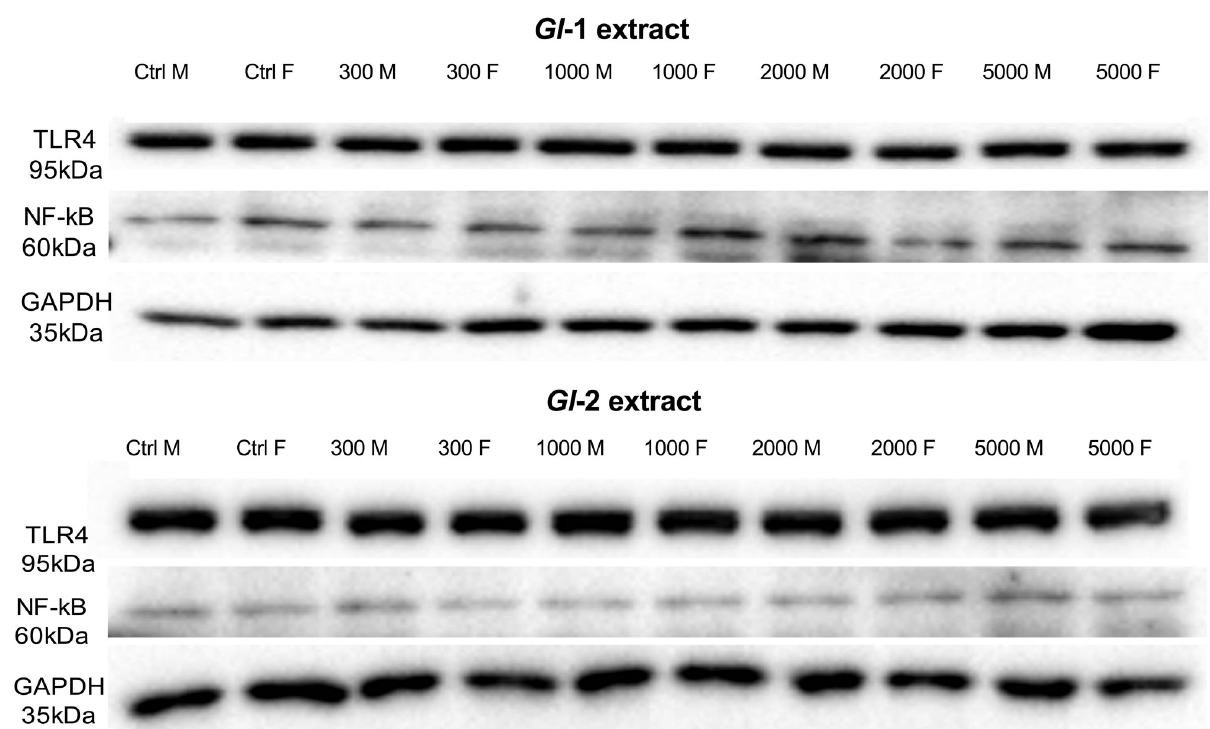
Fig 8. Western blot analyses of TLR4 and NF- к B expression in kidney tissue from male (M) or female (F) Wistar rats fed with the control diet (Ctrl) and different doses of standardized Gl -1 or Gl -2 extracts of Ganoderma lucidum for 14 experimental days. Corresponding densitometry data generated from Western blots are shown in Figs 6 and 7. The dose administered per experimental group is described in the materials and methods section.